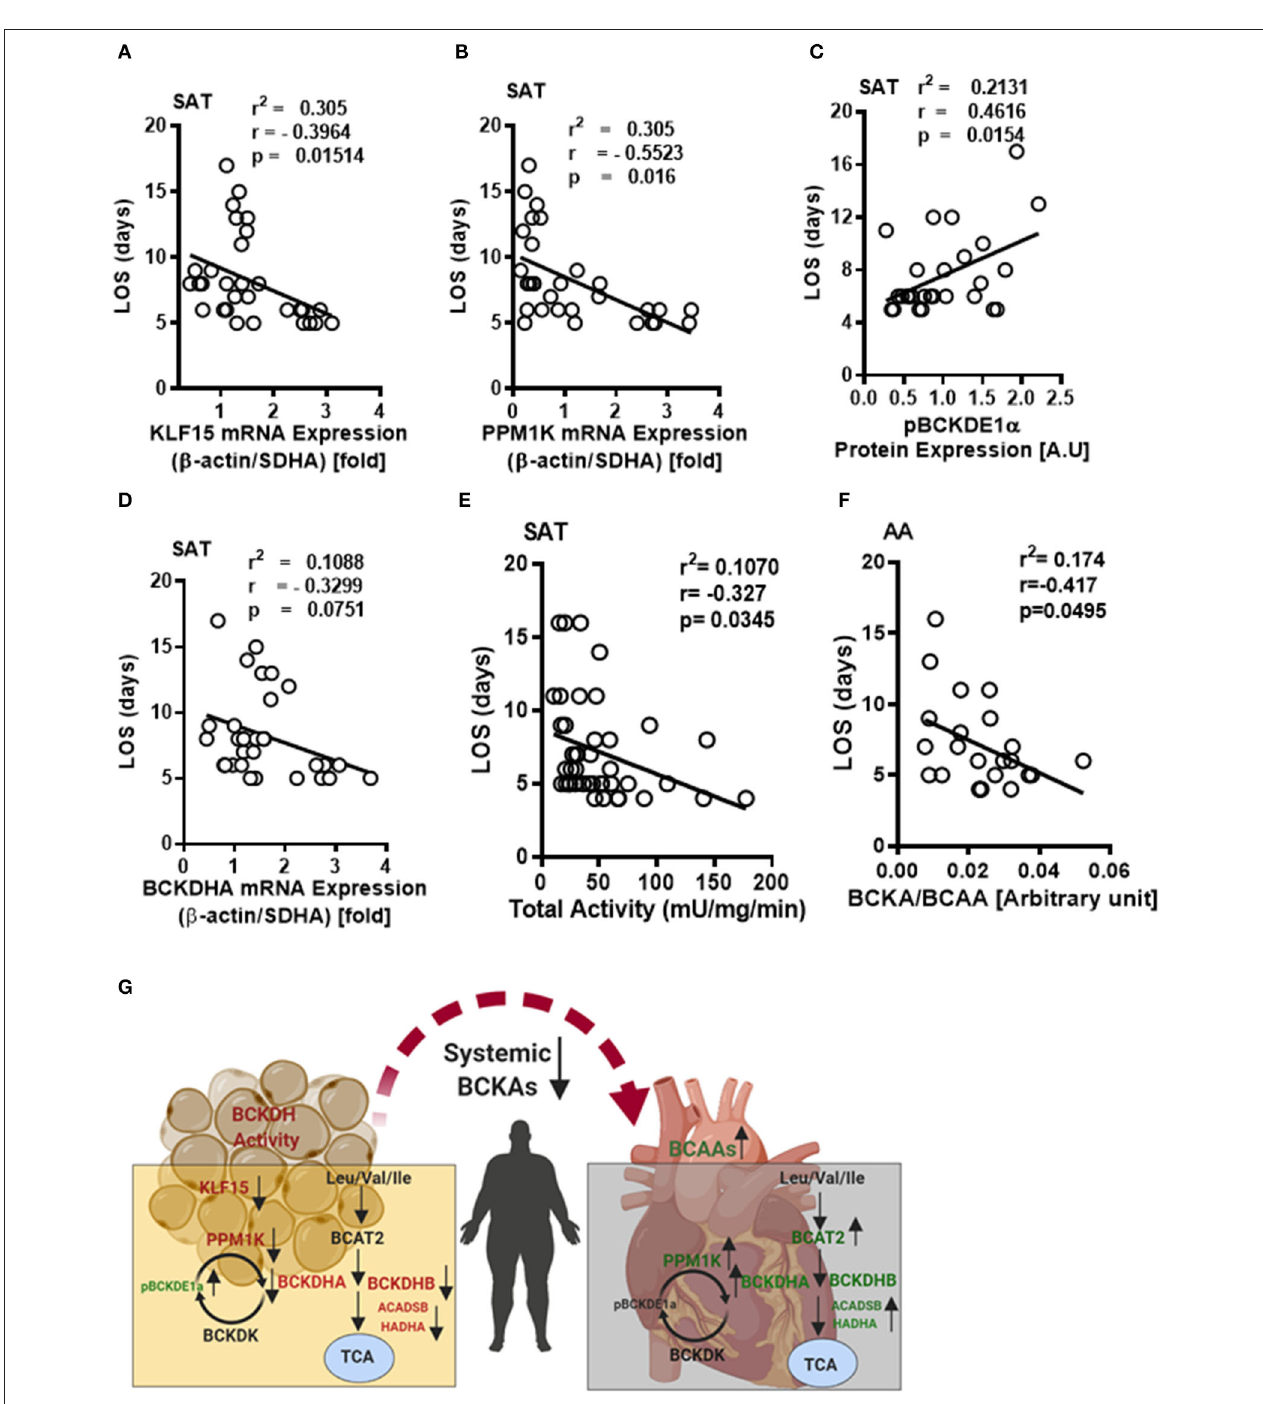
FIGURE 7 | Decreased BCKDH enzyme activity, BCAA metabolic enzyme expressions in the SAT and altered intracellular BCAA levels in the AA are associated with length of stay following cardiac surgery in obese patients. Linear regression of (A) KLF15 , (B) PP1MK mRNA levels, (C) pBCKDE1 α , and (D) BCKDHA protein levels correlated with the length of stay in the hospital following surgery in the SAT of non-obese ( n = 7), pre-obese ( n = 7), class I obese ( n = 8) and class II obese ( n = 6) cardiac surgery patients. (E) Linear regression of total BCKDH activity at Vmax correlated with the duration of stay in the hospital following surgery in the SAT of non-obese ( n = 7), pre-obese ( n = 9), class I obese ( n = 9), class II obese ( n = 9) and class III obese ( n = 8) patients undergoing cardiac surgery. (F) Linear regression of the ratio of intramyocellular BCKA to BCAA correlated with the length of stay following surgery in the AA of non-obese ( n = 5), pre-obese ( n = 5), class I obese ( n = 5), class II obese ( n = 5) and class III obese ( n = 5) cardiac surgery patients. Statistical analysis was performed using one-way ANOVA; followed by a Tukey’s multiple comparison test; p < 0.05 was considered significant. (G) Summary of the tissue specific alterations of BCAA catabolic enzyme expression, BCAA levels and BCKDH enzyme activity in the SAT and AA tissues of cardiac surgery patients with underlying obesity.